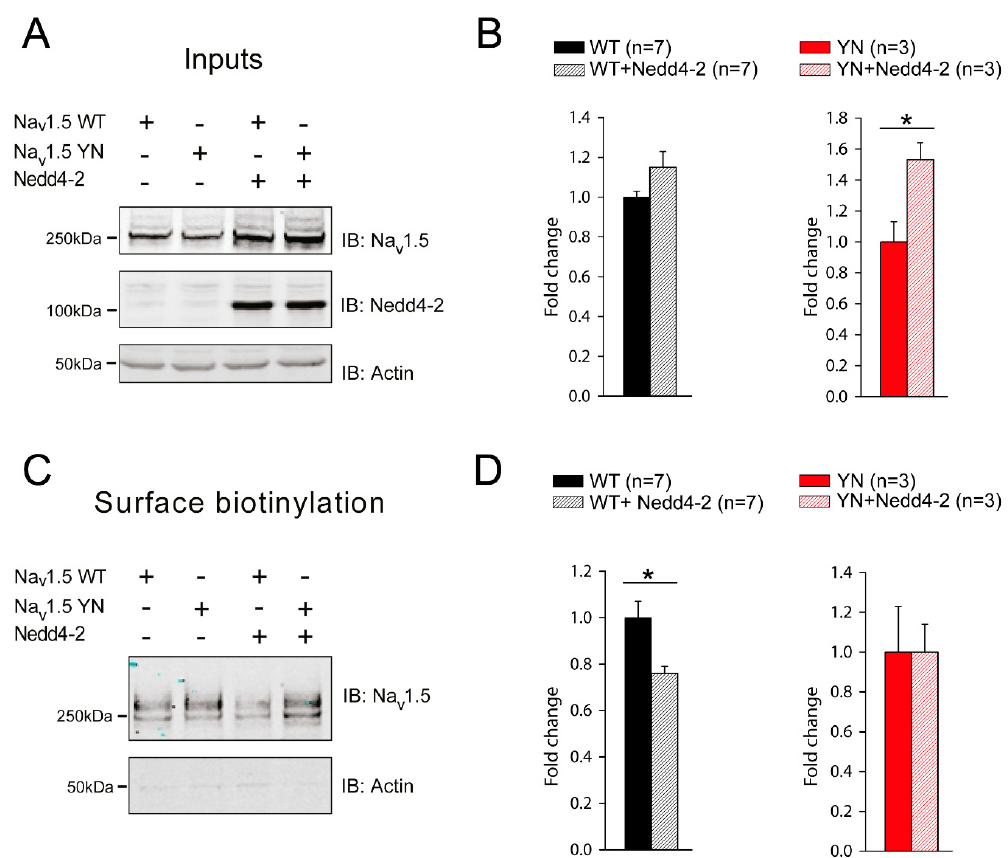
Figure 3. The SCN5A -p.Y1977N mutation abolishes the Nedd4-2 mediated decrease of Na v 1.5 cell surface expression. ( A ) HEK293 cells were transiently transfected with the indicated plasmids and whole cell lysates were blotted against Na v 1.5, Nedd4-2 or actin. ( B ) Fluorescence intensity of Na v 1.5 wild-type (WT) and Y1977N (YN) with or without Nedd4-2, was quantified with LICOR Odyssey software. Data are expressed as fold change compared to the WT or YN group. ( * p < 0.05, Unpaired Student’s t -test; n corresponds to the number of experiments performed) . ( C ) Western blot of a representative cell surface biotinylation assay in HEK293 cells transiently expressing Na v 1.5 WT or YN with or without Nedd4-2. ( D ) Quantification of Na v 1.5 protein at the cell surface in the different